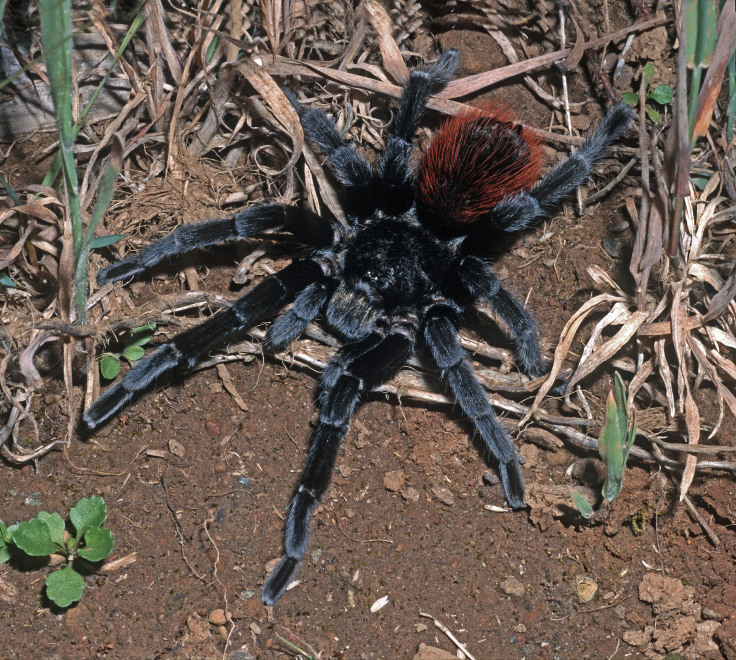
Brachypelma
vagans (Ausserer, 1875) male from Orange Walk District, Belize. Photo: Rick C. West.